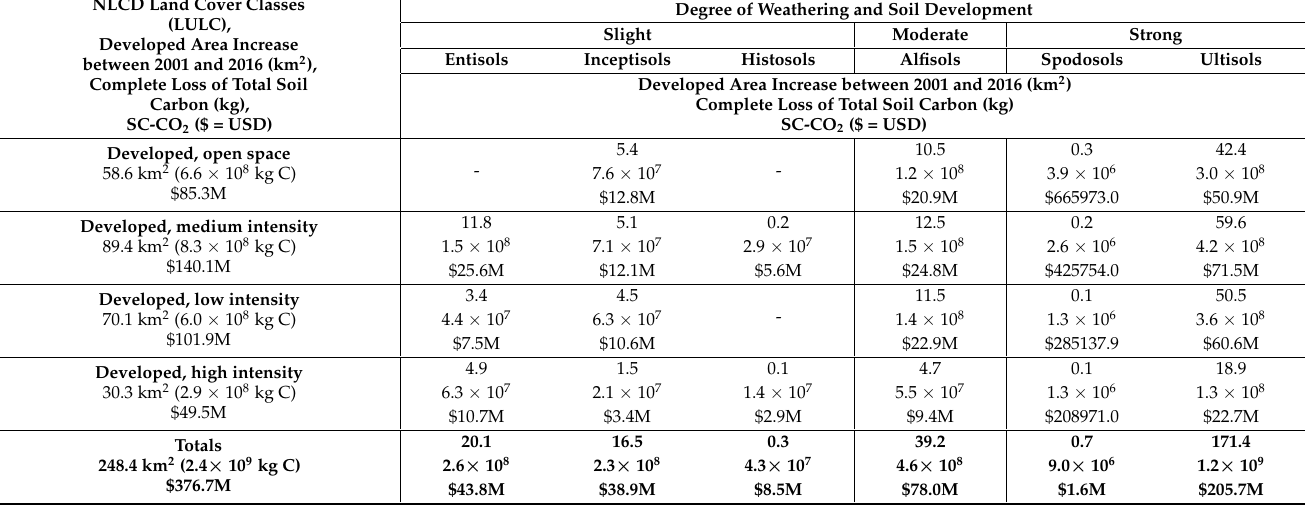
Table 7. Complete loss of total soil carbon (TSC) and the corresponding maximum potential realized social costs of carbon due from developed land for Maryland, USA, between 2001 and